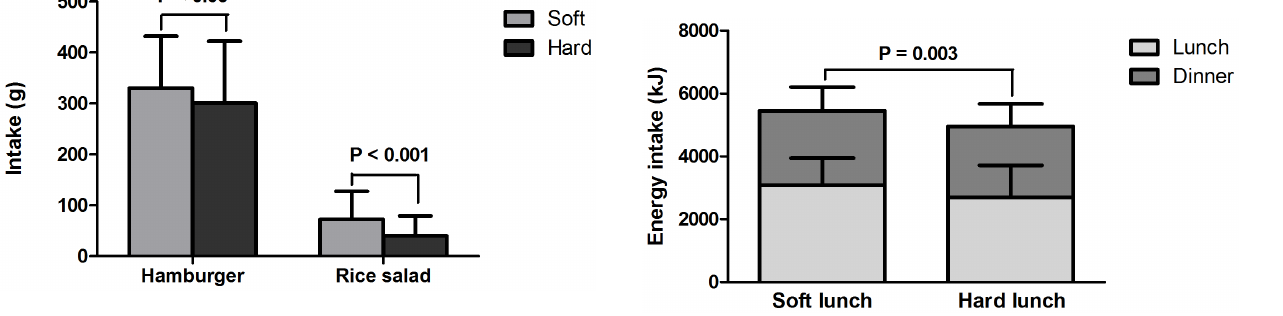
Figure 1. Food intake at lunch of soft and hard foods, n=50 (means + SD). Total is the sum of hamburger and rice salad in either Figure 2. Energy intake at lunch and dinner, n=50 (means and